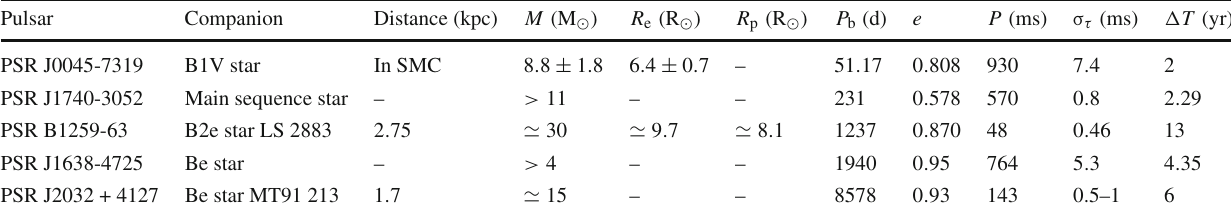
Table 1 Binary pulsars with a massive, fast rotating main sequence star companion discovered so far. For each of them, we list the companion, the distance (when available), the mass M , the equatorial and polar radii R e , R p (when available), the orbital period P b , the orbital eccentricity e , the spin period P , the rms timing residuals σ τ , the data analysis time Pulsar Companion Distance (kpc)